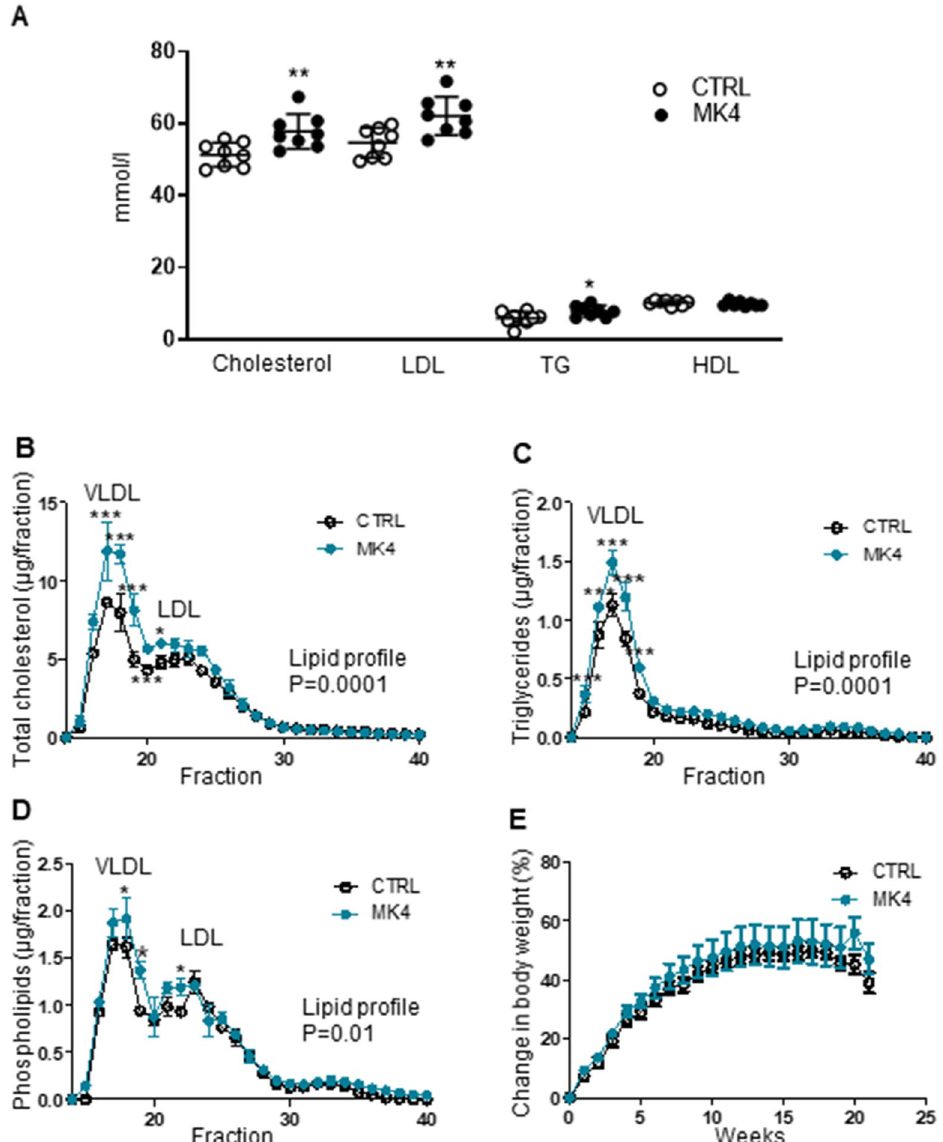
Figure 2. Plasma lipid effects of menaquinone 4 in LDLr −/− ApoB 100/100 mice . ( A ) Plasma lipid levels and ( B – D ) lipoprotein profiles. ( E ) Mice body weight gain. LDL, low-density lipoprotein; TG, triglycerides; HDL, high- density lipoprotein; VLDL, very low-density lipoprotein; CTRL (n = 8–9), LDLr −/− ApoB 100/100 mice on Western diet (WD); MK4 (n = 8), LDLr −/− ApoB 100/100 mice on WD with menaquinone 4. Student´s t-test and 2-way ANOVA with Bonferroni post-hoc test was used for statistical analysis. * p < 0.05, ** p < 0.01, *** p <